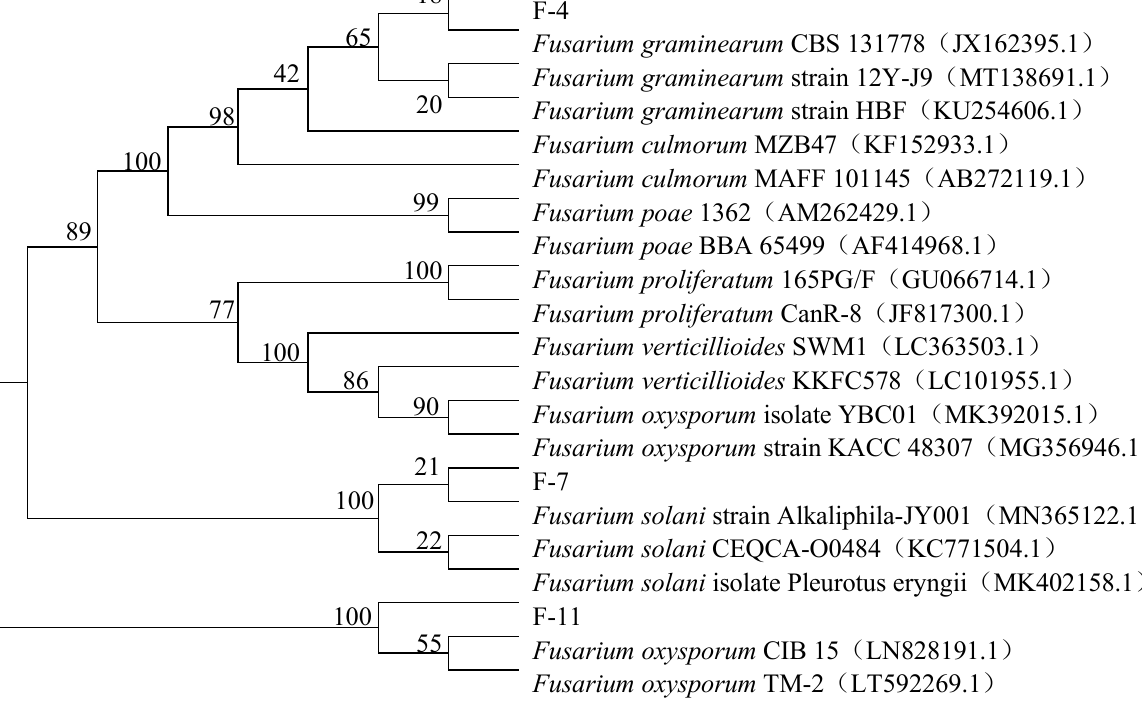
Figure 1. ITS sequence phylogenetic tree of three Fusarium